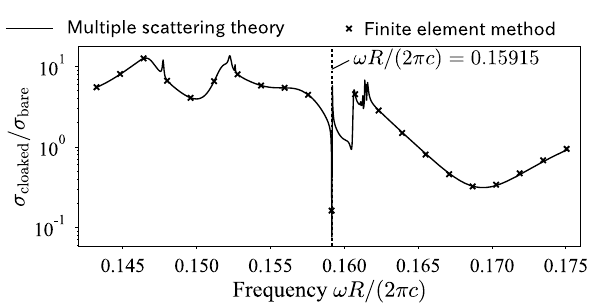
Figure 5. Scattering cross section of the designed cloaked material when the upward-propagating plane wave is given for various